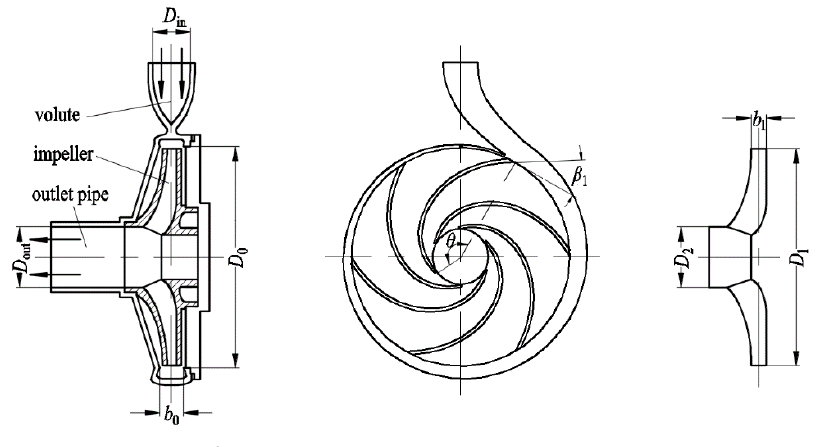
Figure 1. Structure of PAT.